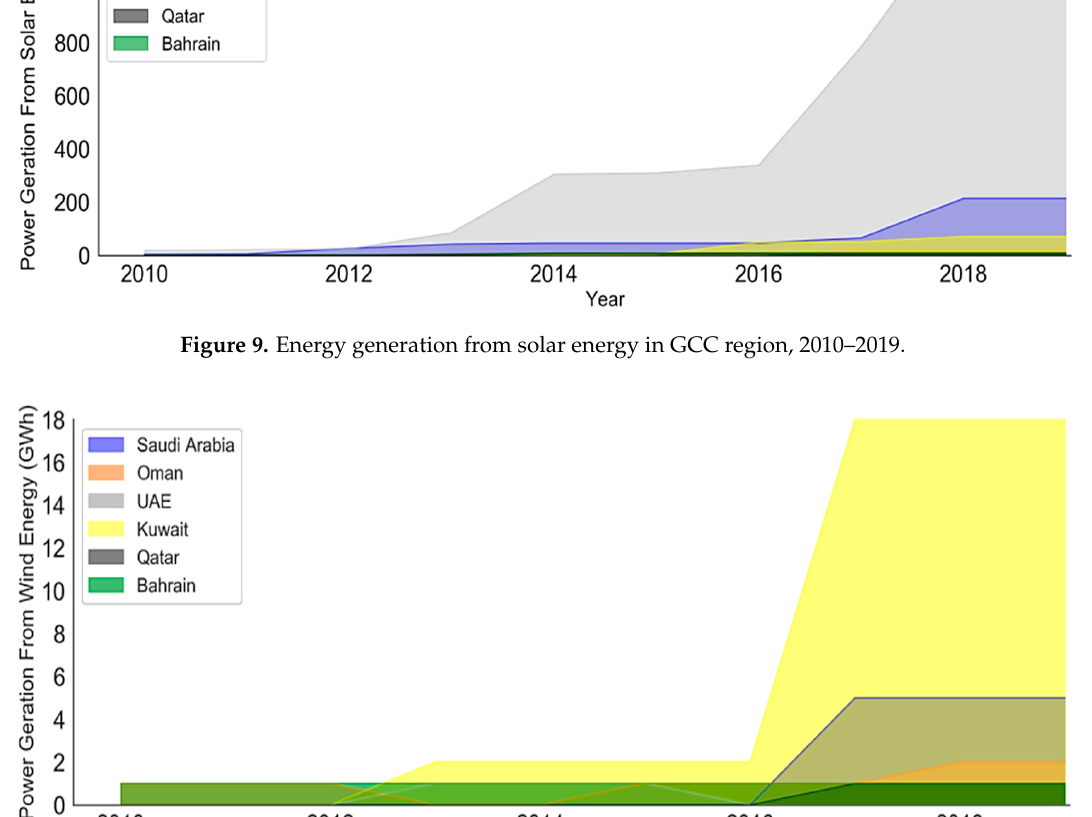
Figure 12. Power installed capacity from wind energy in GCC region, 2010–2019. 6. Climate Justice The pursuit of climate justice forces us to ask serious questions about how we properly measure and address environmental inequality. Climate justice politics are rife with controversy about the existence and geographic scope of both the issue and its po- tential remedies. Adger [115] mentioned that the UNFCCC is the main body organizing international cooperation in response to the dangers of global climate change. Adaptation is used as a justification for international transfers in the convention framework to com- pensate for and brace for future or actual impacts. The argument that improving sustain- ability would improve adaptive capability and that planning activities are a vital part of overall adaptation can be used to justify this strategy [115]. Schlosberg [116] reported that environmental justice campaigns are not solely concerned with individual consumer ap- proaches to climate change issues—they do not just imply the use of solar panels on roof- tops. Schlosberg [116] believes that the emphasis must be on developing innovative sus- tainable strategies and structures—practices and institutions that reflect not only environ- mental justice values, but also a wider definition of sustainability. In addition, effort must be put into eliminating harmful activities, such as coal mining and burning, mining cor- porations’ misdeeds, and controlling the growth of consumption. As the main producers and exporters of oil and gas, the GCC countries will be constantly criticized by the inter- national community and the environmental lobbying groups. The region needs new en- vironmental regulations, as well as increased governmental support, including accelerat-